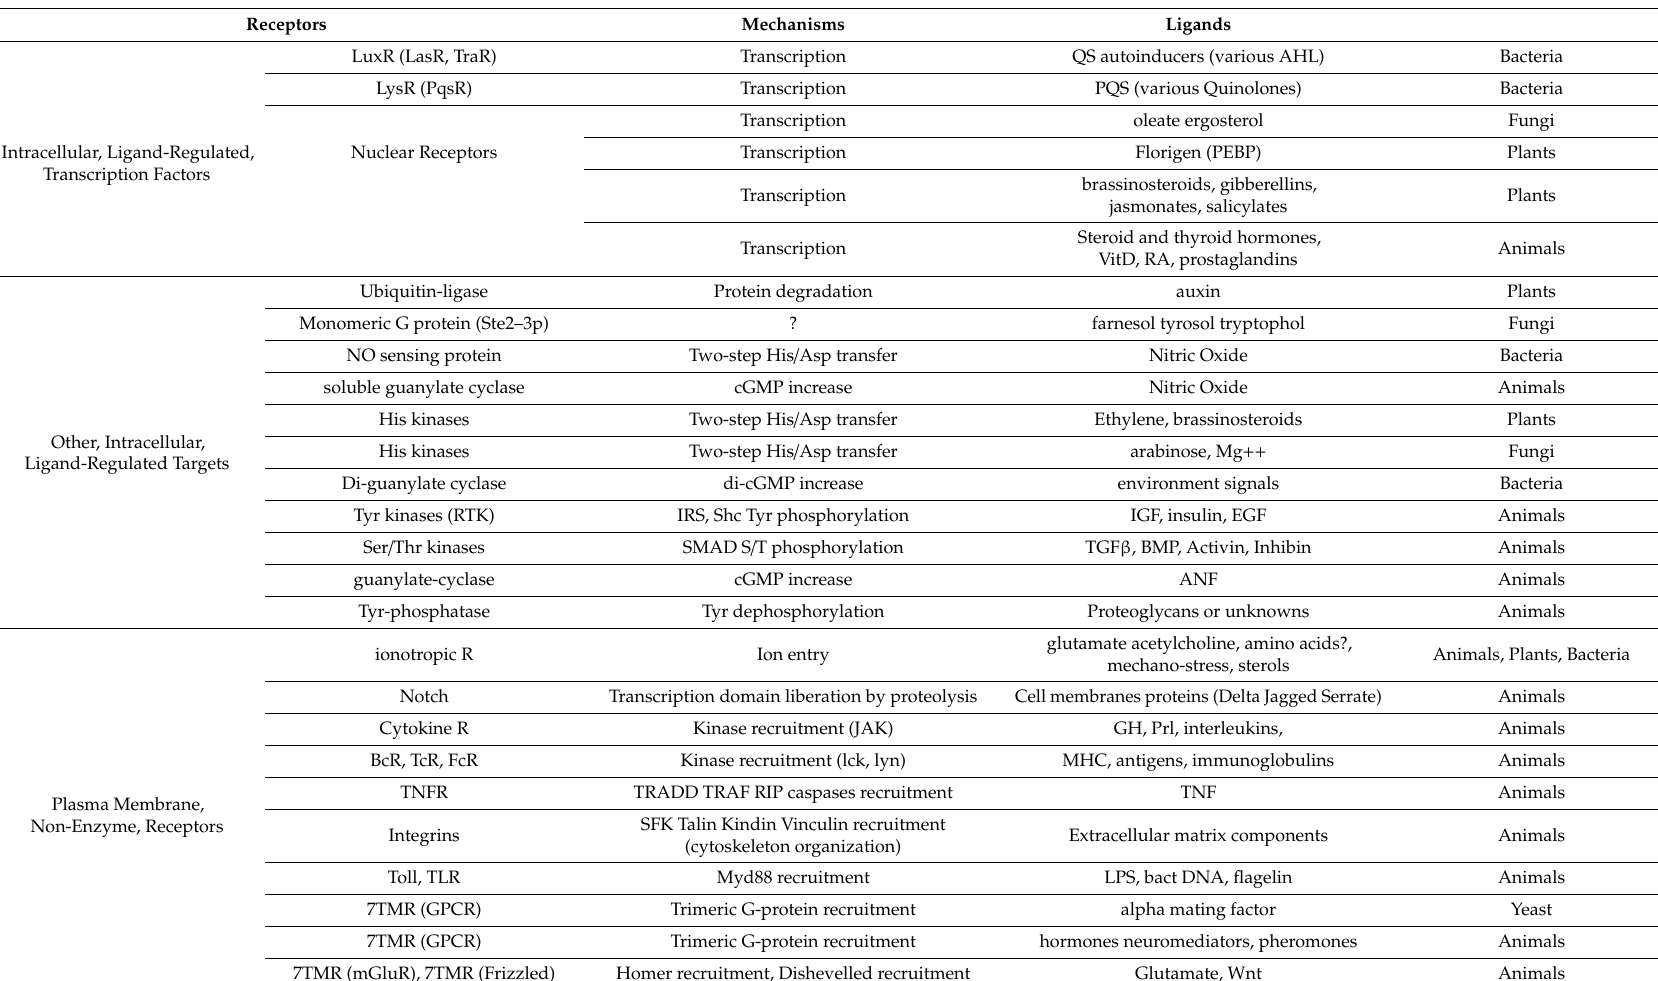
Table 1. Intracellular and membrane receptor families in microorganisms, plants, and animals. GPCR, G protein-coupled receptor; AHL, N-Acyl homoserine lactone; NO, nitrogen oxide; TLR, toll-like receptor; QS, quorum sensing; PQS, pseudomonas quinolone signal; LPS,